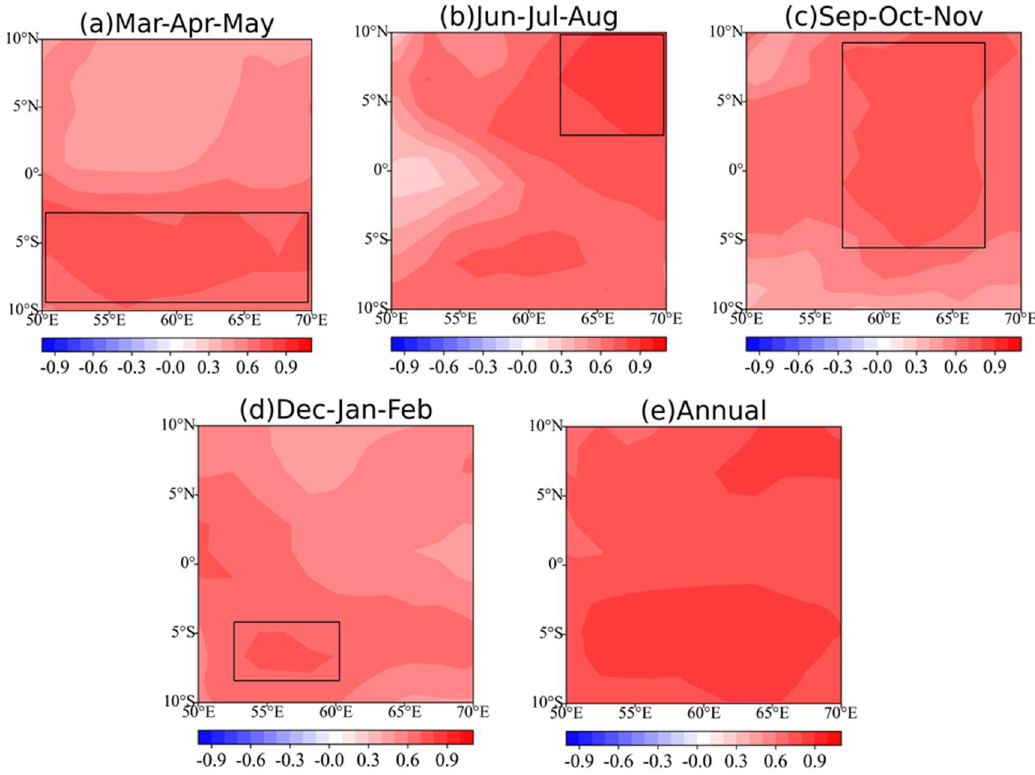
Figure 15. Correlation distribution between WHWP and SST in the tropical western Indian Ocean. The area enclosed by the black box in the figure is the high value area of the correlation coefficient. ( a ) Mar-Apr-May; ( b ) Jun-Jul-Aug; ( c ) Sep-Oct-Nov; ( d ) Dec-Jan-Feb; ( e ) annual.